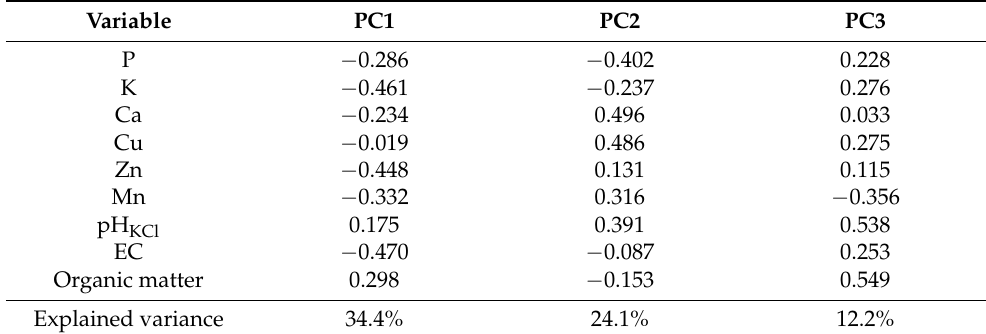
Table 3. Eigenvector values of principal component analysis of peat samples describing correlations with the first three components.